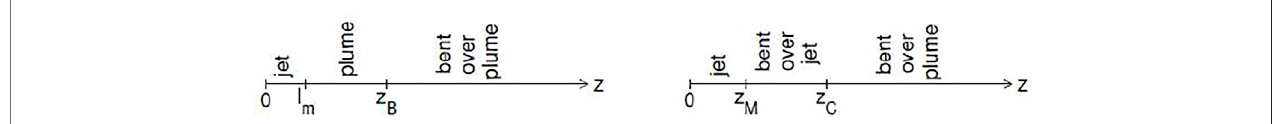
) 1/3 , (de Wit, 2015). B